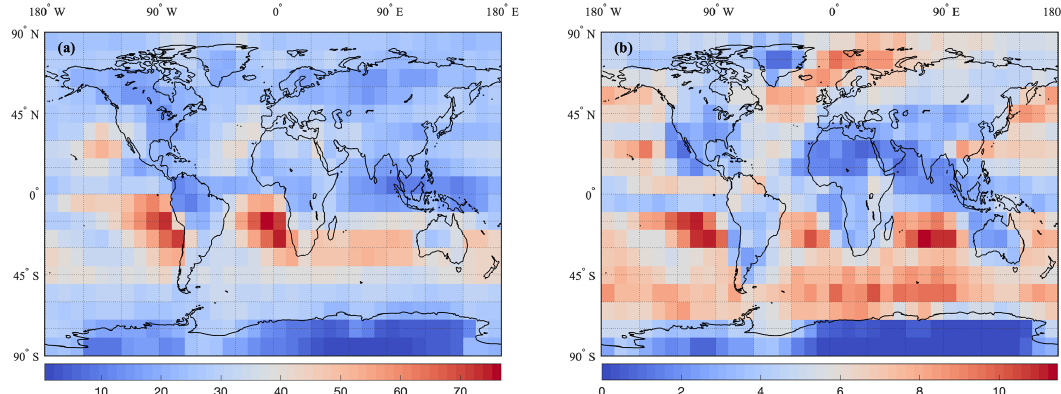
Figure 2. Geographic distribution of cloud scenes (Sc) and (Ac, Sc) in panels (a) and (b) respectively, in units of percentage with respect to all of the (194) observed cloud scenes. These scenes were observed at the AMSU FOR resolution ( ∼ 45km). Similar plots of the AIRS FOV resolution ( ∼ 15km) are nearly identical (not